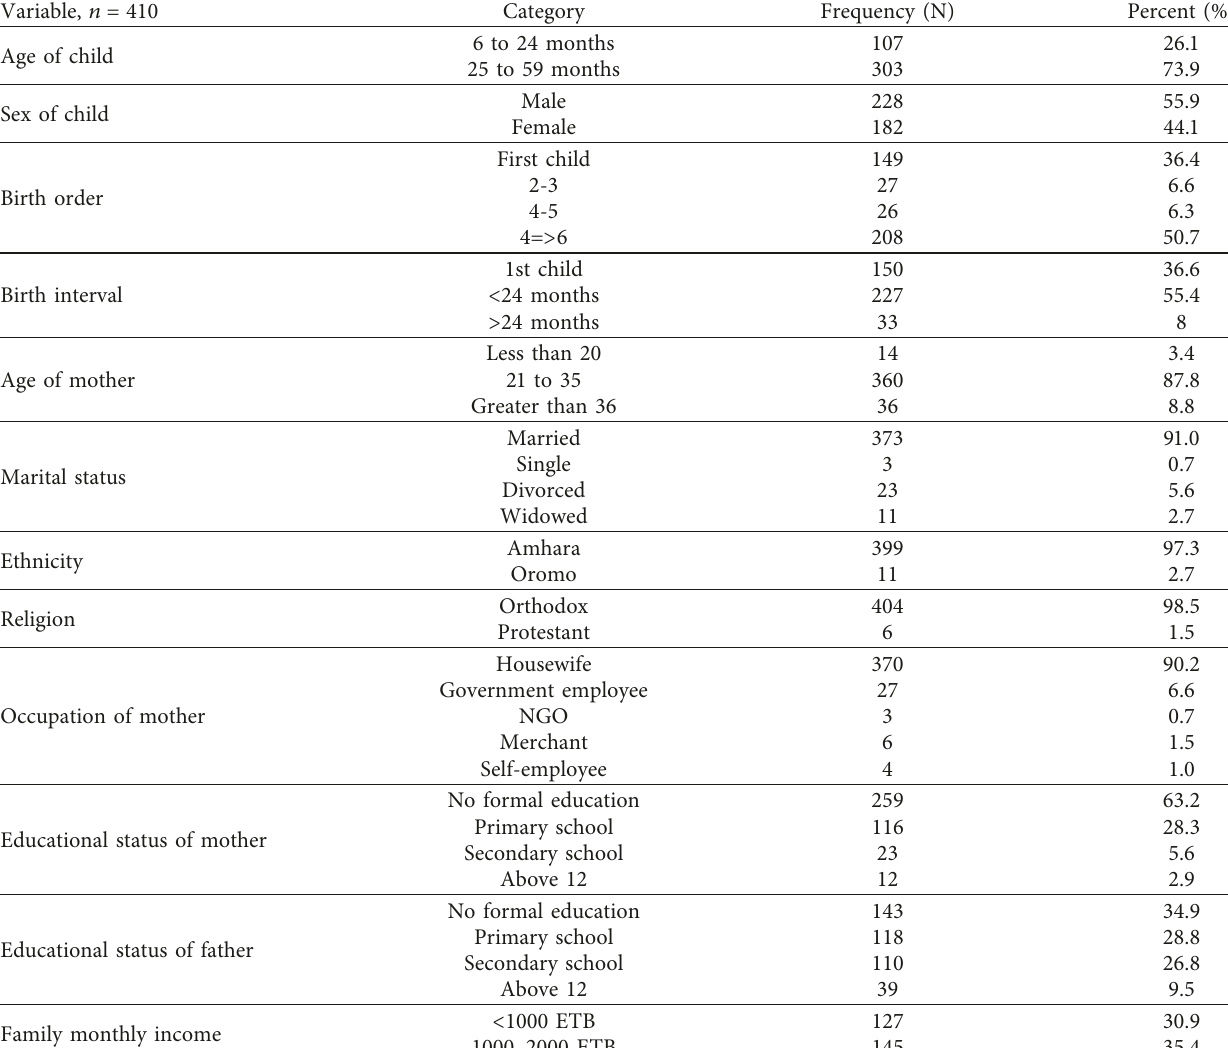
Table 1: Demographics and socioeconomic characteristics of children aged 6 to 59 months in Merhabete woreda, Ethiopia, 2017 ( n � 410). Variable, n �